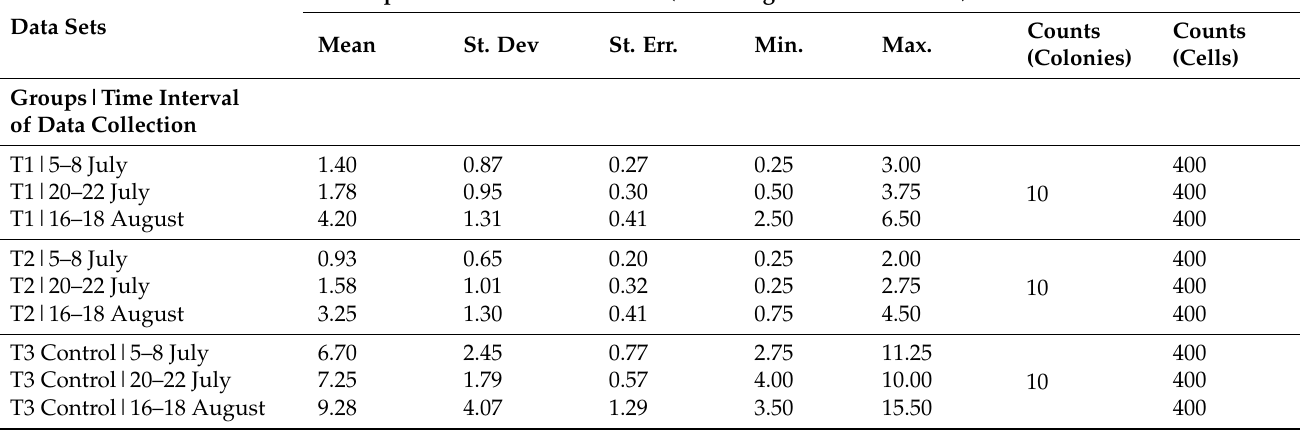
Table 1. The basic descriptive statistics of data regarding the percentage of varroa mite infested cells evaluated at different time intervals, in the experimental and control